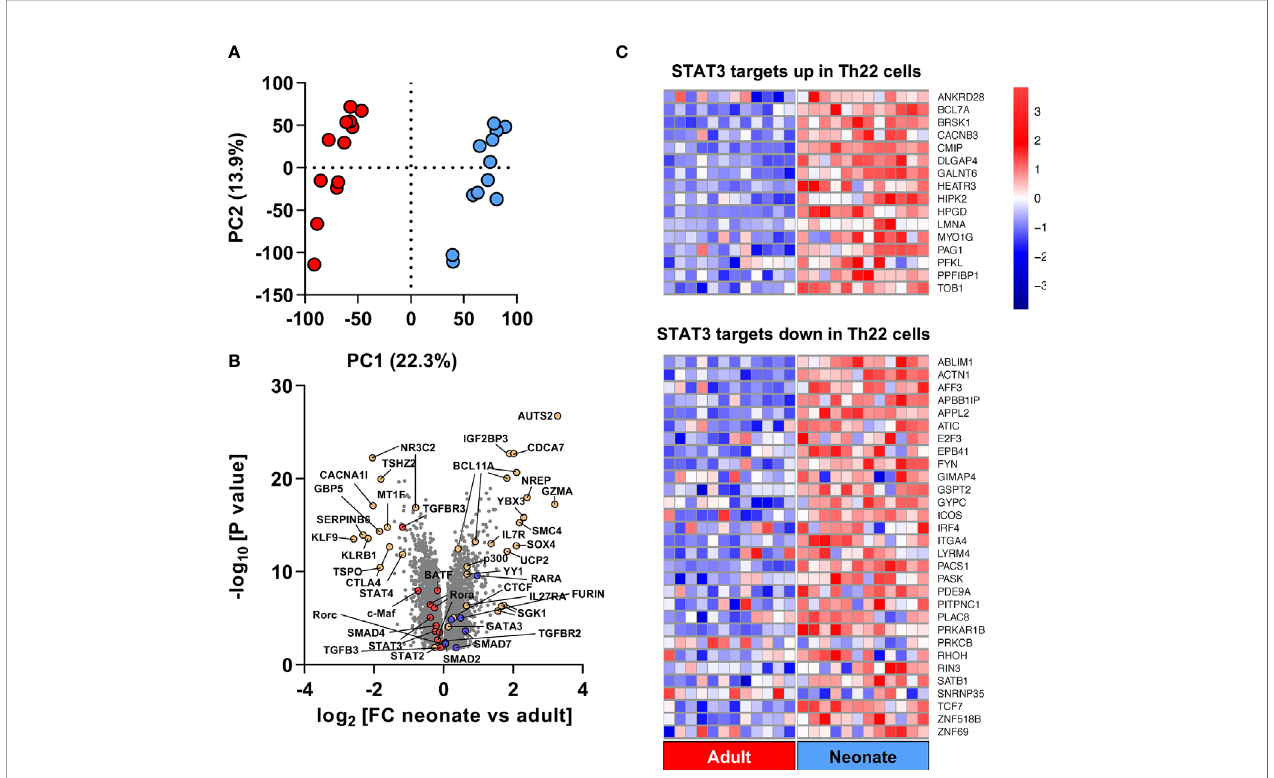
FIGURE 2 | Genome-wide gene expression comparison identi fi es a unique developmental Th22 signature at baseline in naïve neonatal CD4 T cells. (A) Principal Component Analysis using above-intensity gene expression probes between unstimulated adult (red) and neonatal (blue) naïve CD4 T cells; (B) Volcano plot of fold- change and unadjusted p values of genes expressed differentially by neonatal and adult naïve CD4 T cells. TGF- b - and Th17-related genes with higher expression in adults are shown in red whereas genes with higher expression in neonates are shown in blue; (C) Heatmap of genes overlapping between STAT3 leading edge genes from the Chromatin Immunoprecipitation Enrichment Analysis (ChEA) database ( Supplementary Table S5 ), and upregulated/down-regulated genes in Th22 cells compared to Th1, Th2 and Th17 cells based on (22). Red and blue colors in heat map represent Z-score for upregulated and downregulated genes in neonates compared to adults,